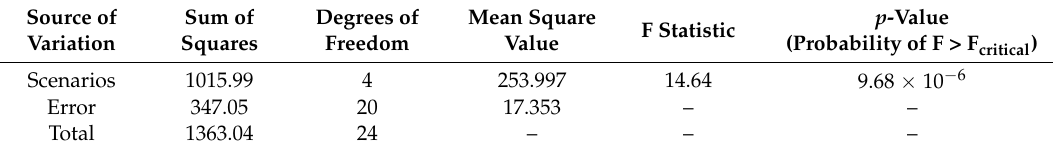
Table 3. Standard ANOVA results for the comparison of mean errors from the different scenarios.